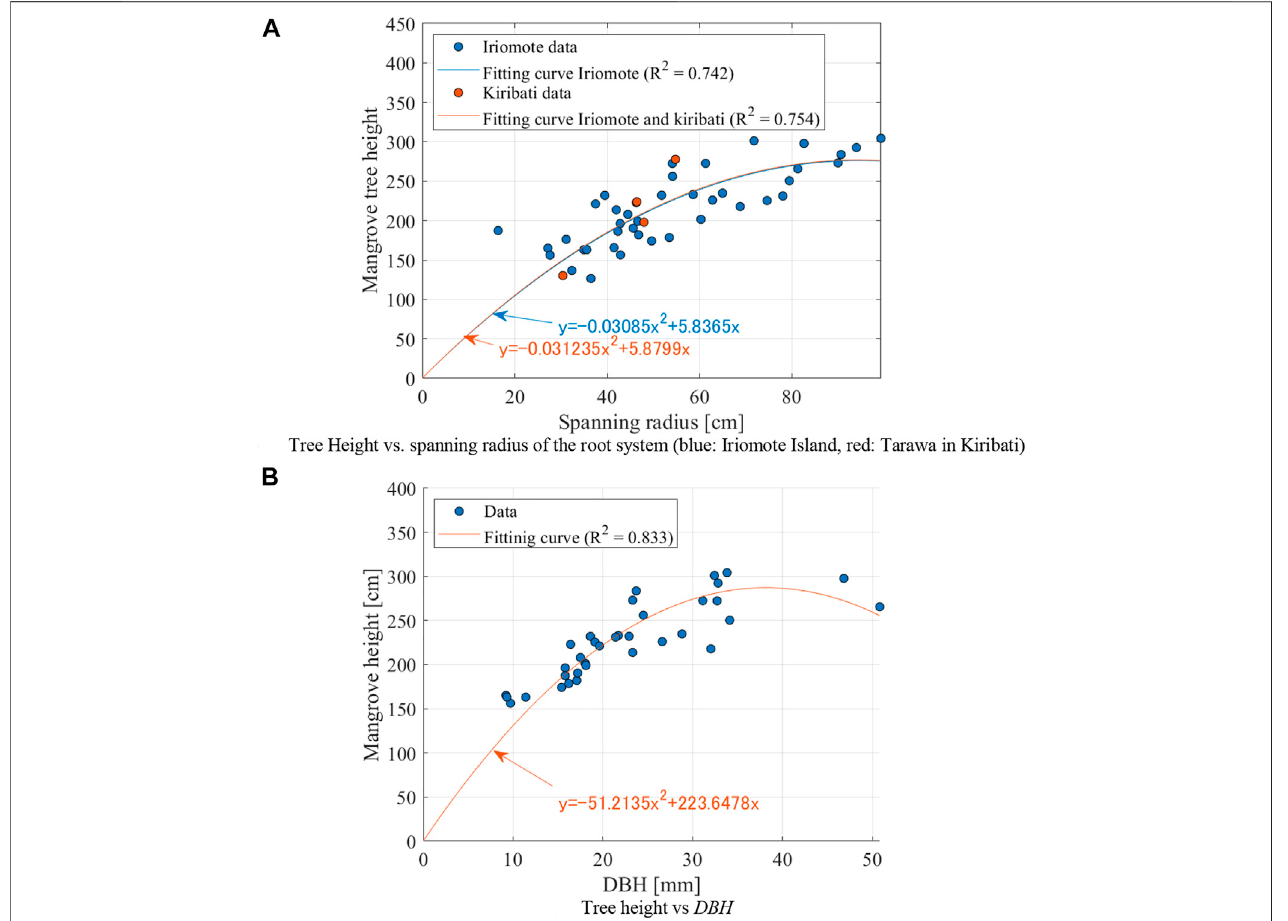
FIGURE 3 | Relationship of the tree height H with the spanning radius of the root system W and DBH (circles: measured data, solid lines: regression curve) ( Rhizophora stylosa ). (A) A* root vs DBH. (B) A* root vs H* root .